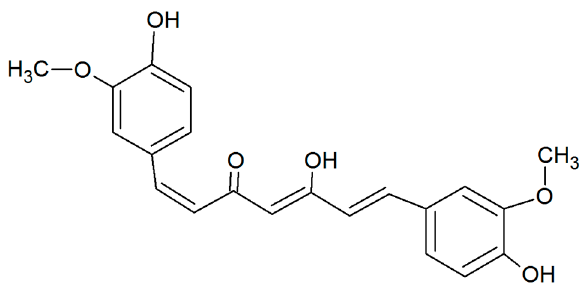
Figure 1. Chemical structure of curcumin.